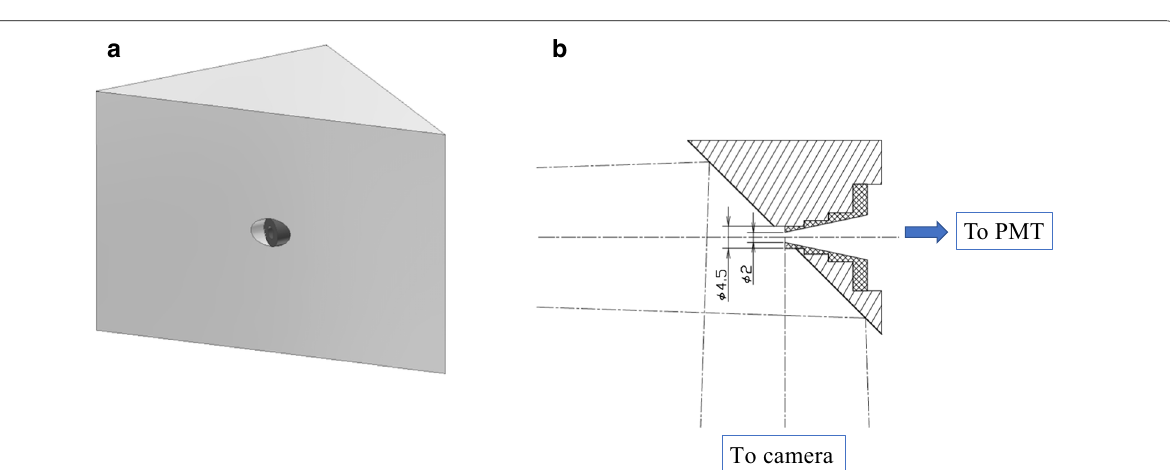
Fig. 2 a Schematic diagram of the divider part (pinhole) of the photometer. b Cross-section diagram of the divider part of the photometer. Unit is in